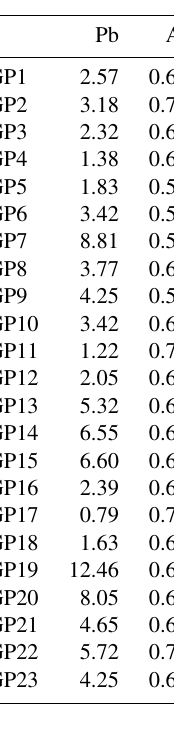
Table 2. Enrichment factor analysis of Gunn Point aerosol